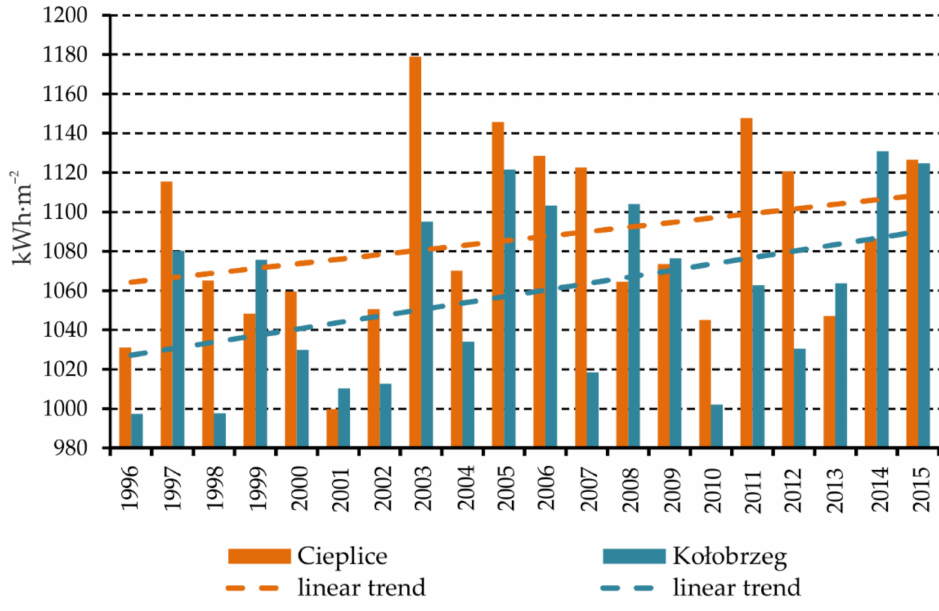
Figure 7. Annual sums of global solar radiation in Cieplice and Kołobrzeg in the years 1996–2015.